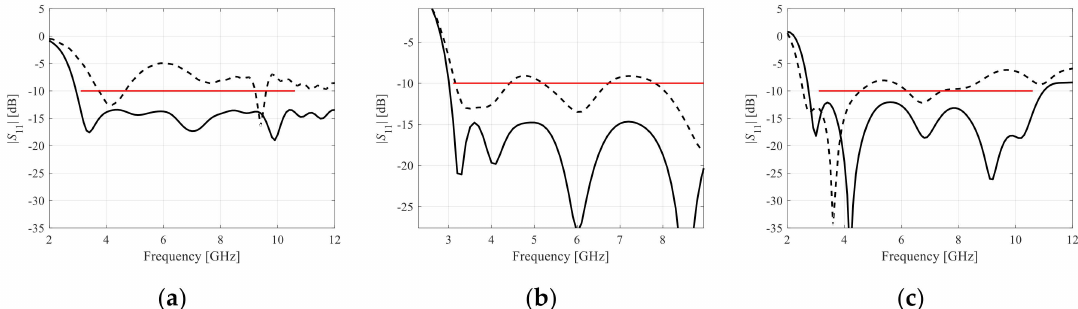
Figure 4. Initial (- - -) and optimized (—) responses of the antennas found using the proposed variable-fidelity algorithm, shown for the representative runs of the procedure: ( a ) Antenna I, ( b ) Antenna II, ( c ) Antenna III. Horizontal lines mark the design specifications. Table 2. Optimal geometry parameter vectors for the representative algorithm runs of Figure 4. Antenna Geometry Parameter Values